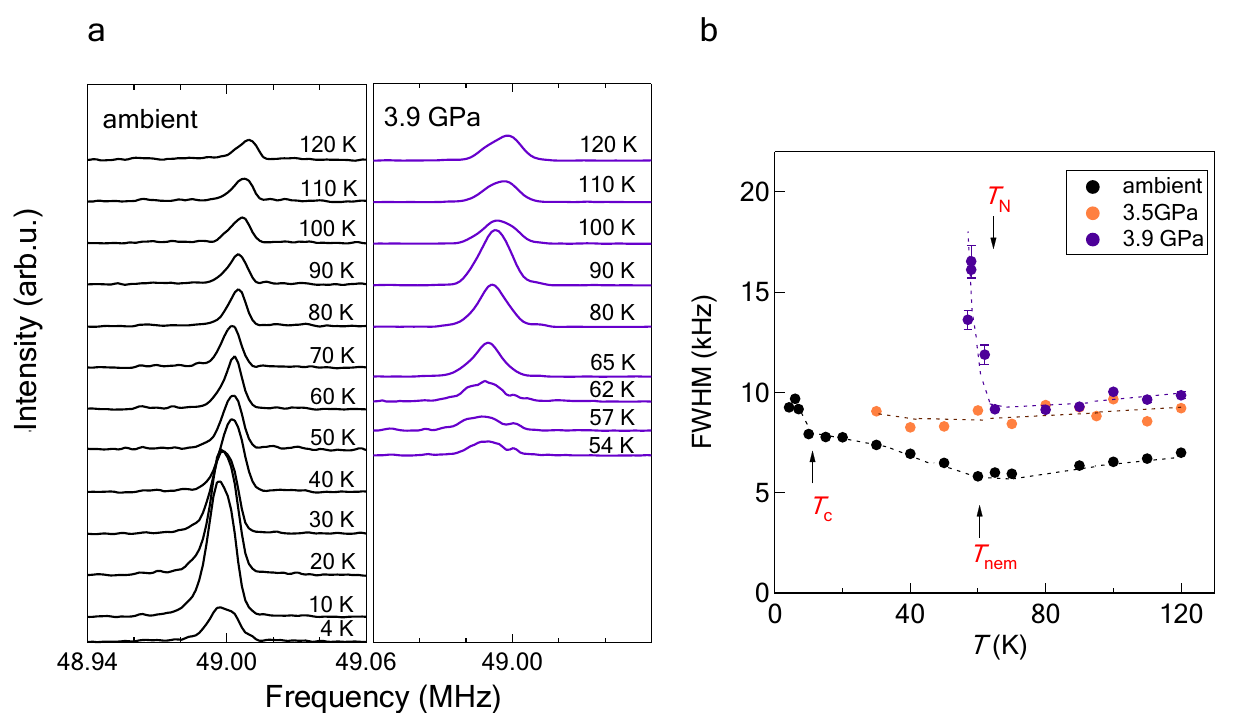
Figure 2. Typical 77 Se-NMR spectra and linewidth for 12% S-substituted FeSe corresponding to the nematic and antiferromagnetic (AF) orders. ( a ) The NMR spectra at ambient pressure show a double-edge structure in the nematic phase below 60 K 20 . The NMR spectra at 3.9 GPa broaden remarkably, and the signal is not observed below the AF transition temperature T N . ( b ) Full width at half maximum at 3.5 and 3.9 GPa. The arrows shown by T nem and T c represent the nematic and superconducting transition temperatures, respectively 20